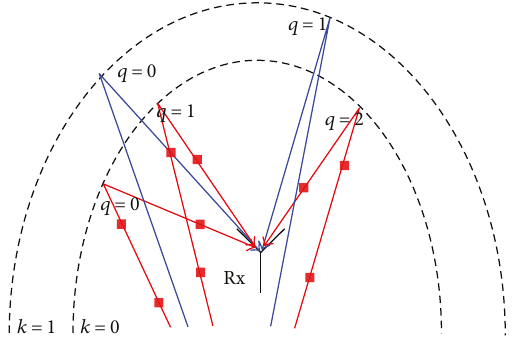
Figure 2: Signal path